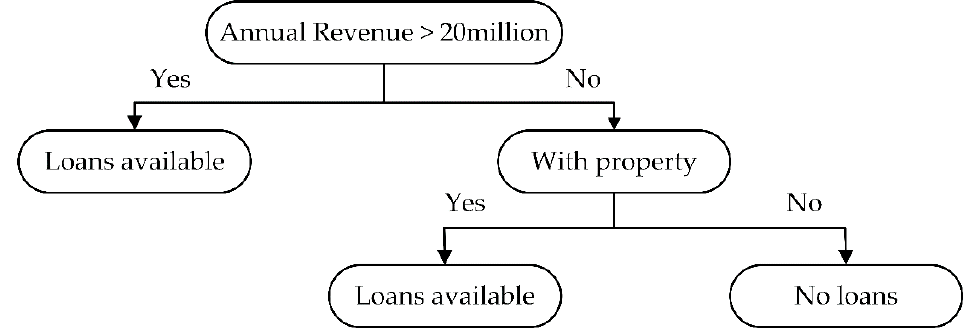
Figure 8. Schematic diagram of the decision tree.